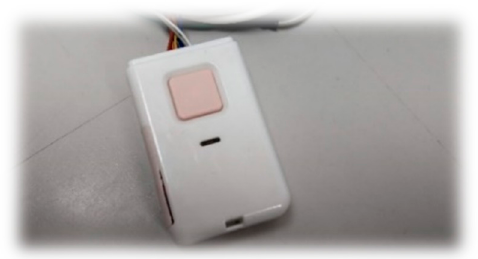
Figure 10. Wireless multi-channel physiological signal recording system.